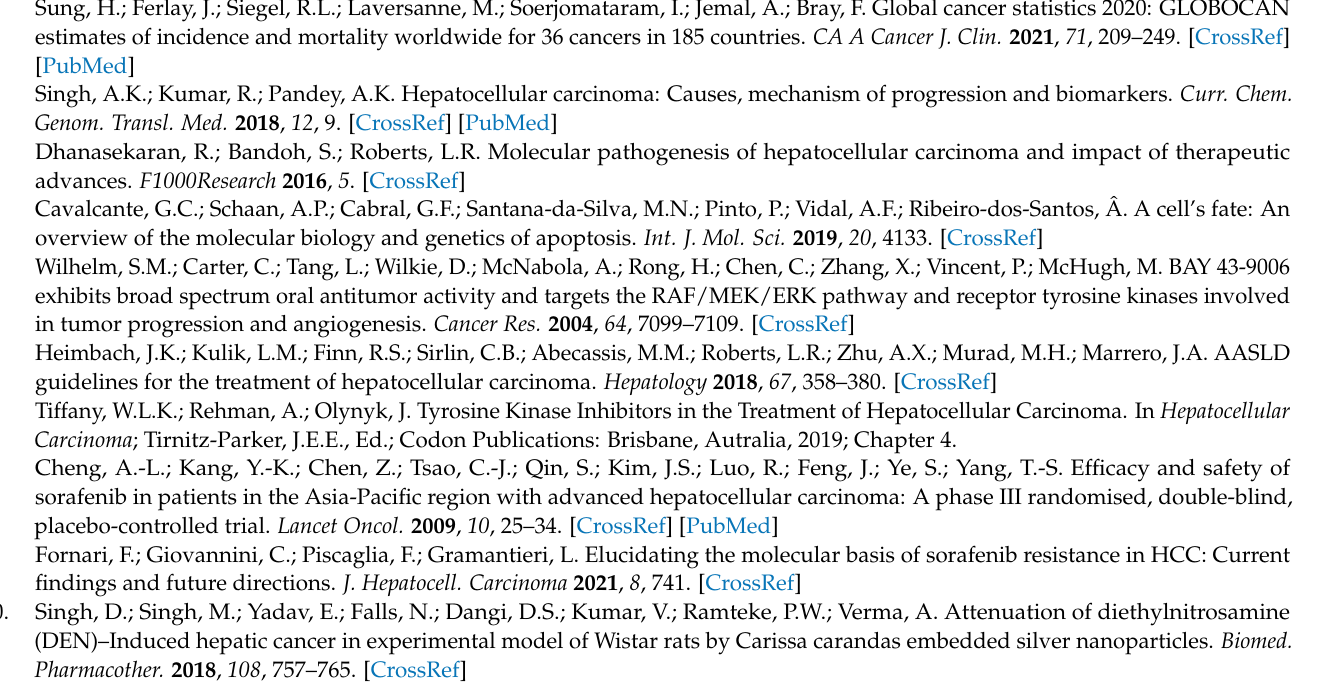
Figure S2: Zeta potential of Spirulina Platensis NSP; Figure S3: Particle size of Spirulina Platensis NSP; Figure S4: Scanning of Spirulina Platensis NSP; Table S1: The percentage of expression of both